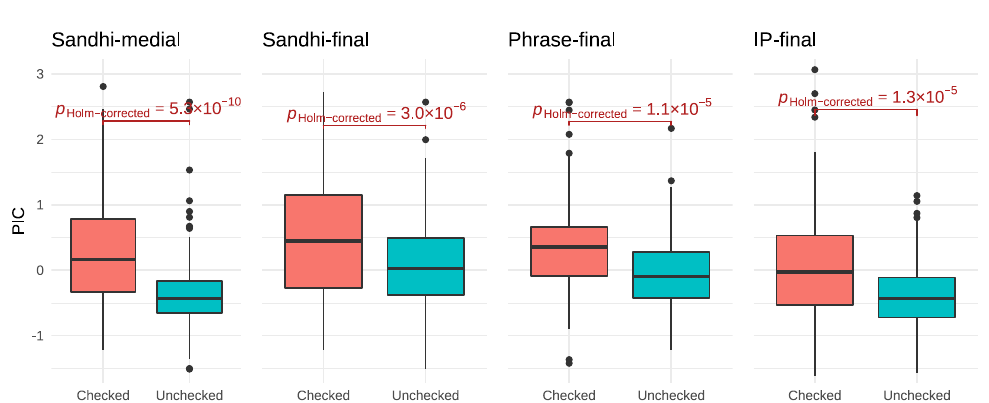
Figure 7. The variation of PIC influenced by phonemic type and prosodic position. Significant p ‑ values ( p ⩽ 0.05 ) are marked in red, which indicates that the PIC difference between checked and unchecked syllables is significant in that prosodic